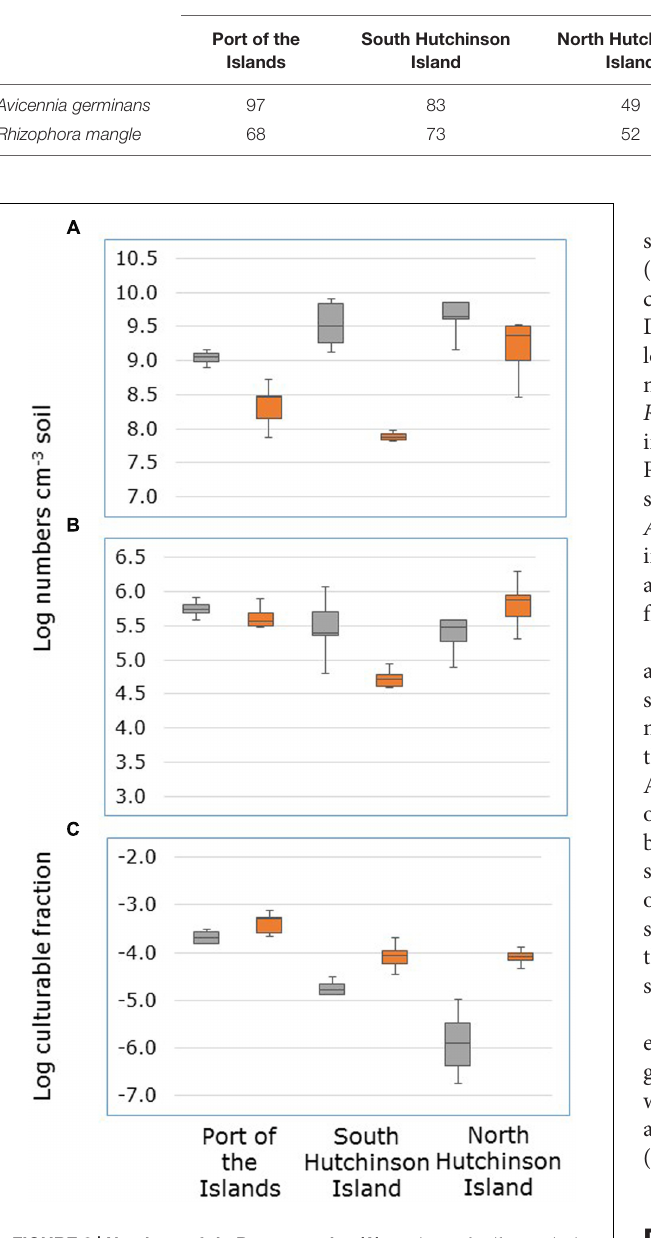
numbers of the dsrB gene and by establishing the number of cells able to grow in APL medium by an MPN method. Numbers of these latter cells were on average 96000 times lower than the copy